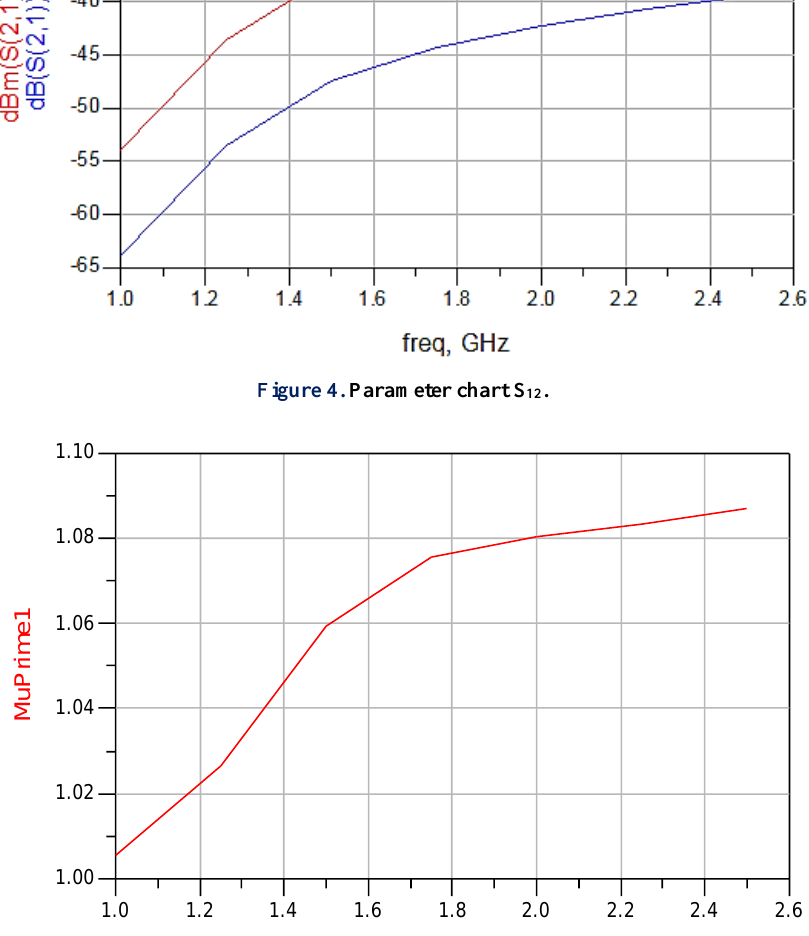
Figure 3. Parameter chart S 11 .